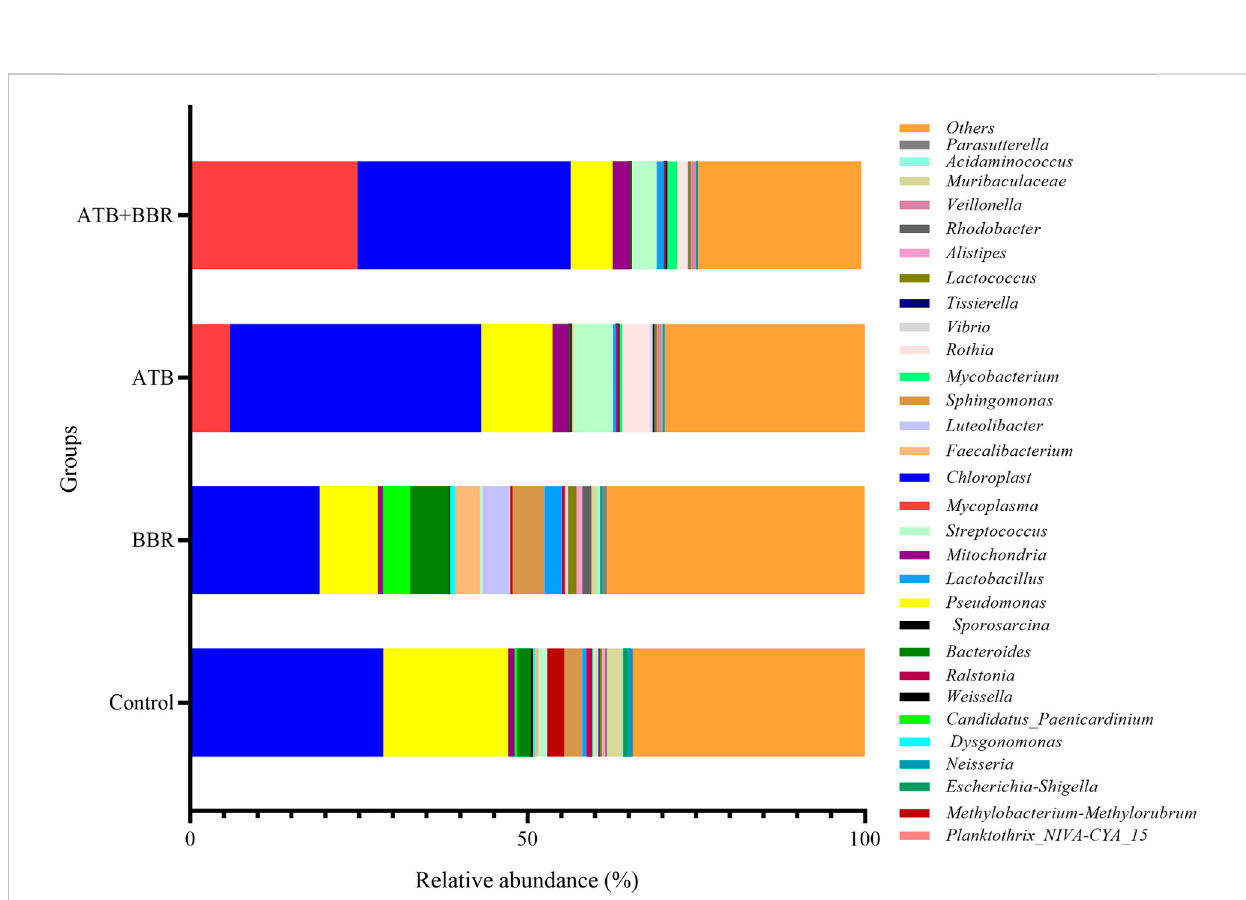
FIGURE 2 Composition of gut microbiota at the genus level in largemouth bass. BBR, berberine; ATB,